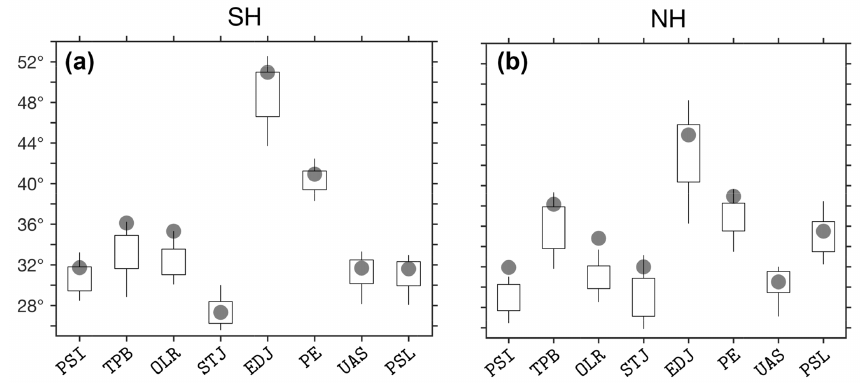
Figure 11. The mean SH (a) and NH (b) latitudes of the default methods in each of the eight metrics, derived from annual means, for the period 1979–2004. Positive values are used for both the NH and SH. Candle boxes show mean ± 1 standard deviation of CMIP5 inter- model spread. Candle wicks show maximal and minimal CMIP5 model values. ERAI values are shown in gray dots. The input parameter Lat_Uncertainty is set to zero (default) in all of the relevant